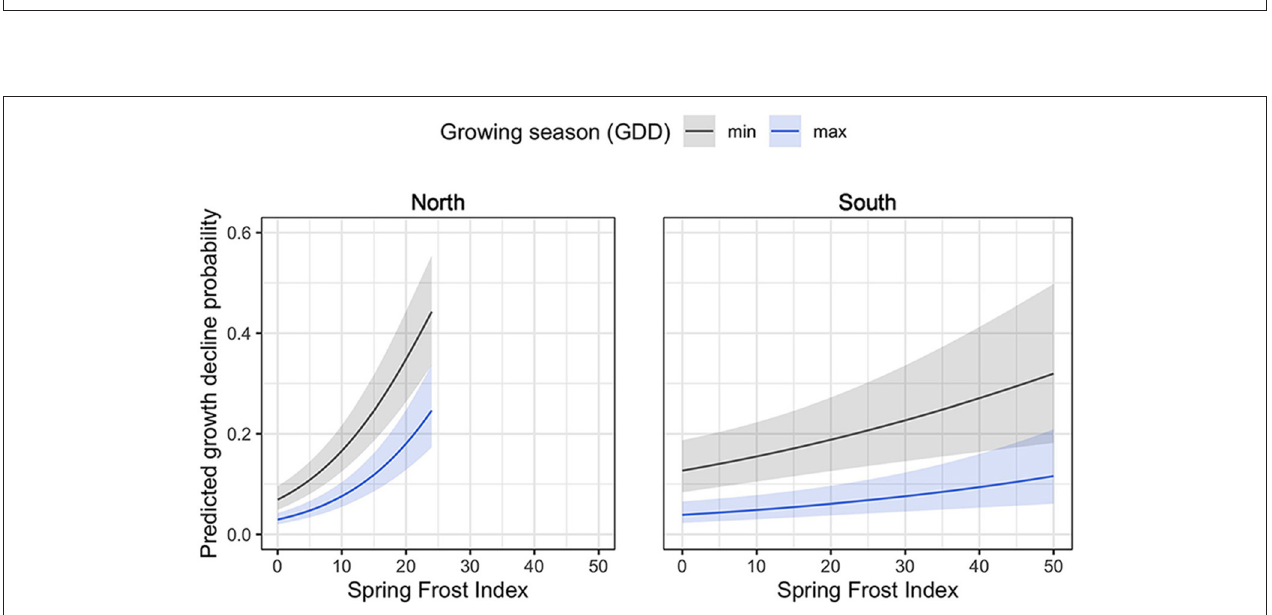
FIGURE 5 | Mean predicted abrupt growth decline probability as affected by accumulated GDD during spring frost (spring frost index) and observed minimum and maximum growing season GDD for the northern and southern regions. Confidence intervals of growth decline predictions (shaded area) were calculated with α = 0.05.